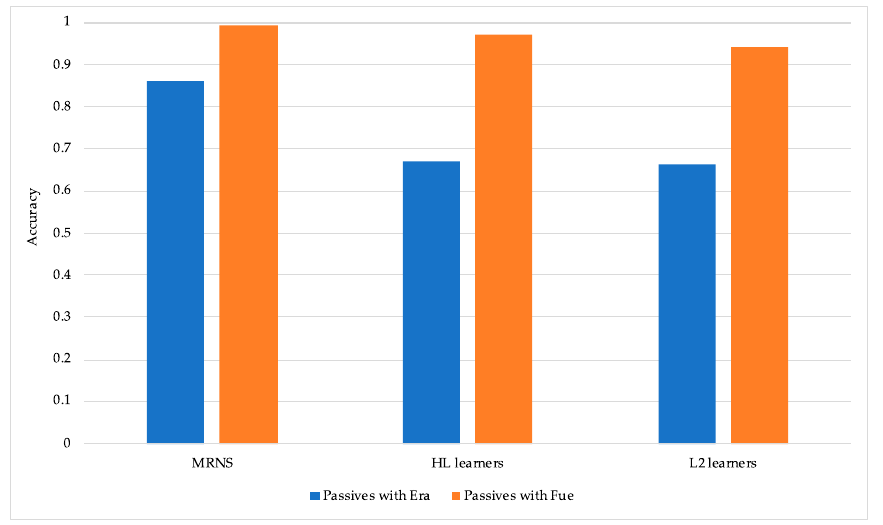
Figure 4. GJT: Mean accuracy ratings on grammatical passives with era and fue.